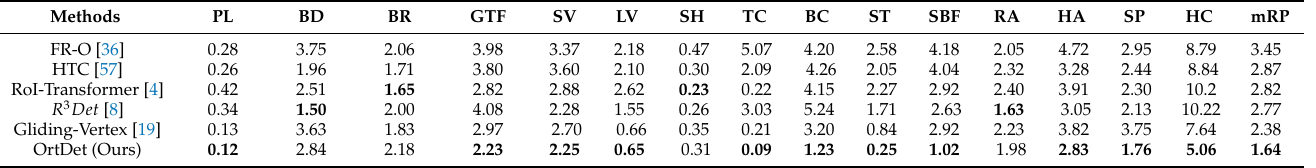
Table 4. Mean rotation precision (%) of the different methods for the DOTA-v1.0